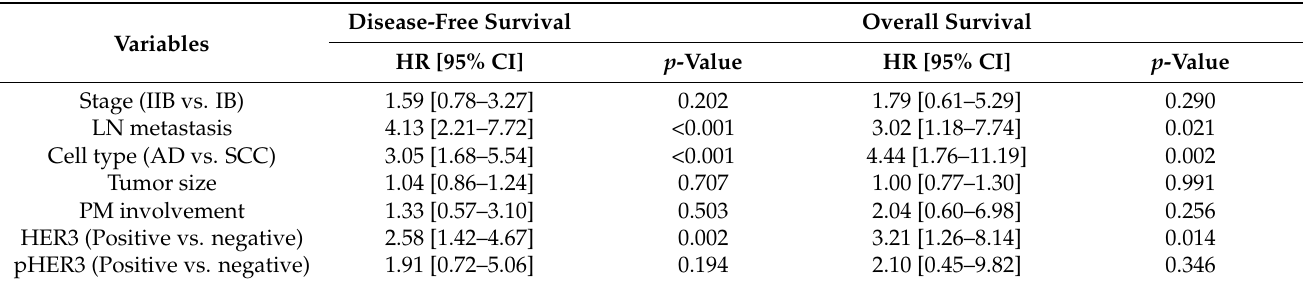
Table 2. Multivariate analysis of the relationship between prognostic factors and survival in cervical cancer